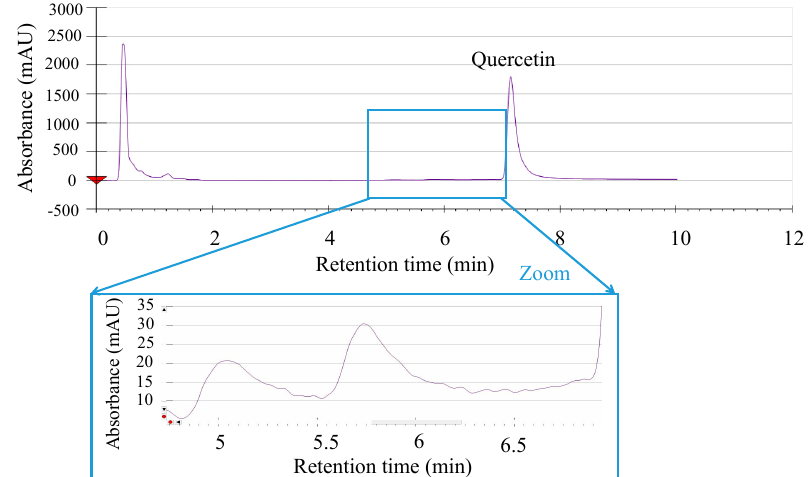
Figure 1. A supercritical fluid chromatography separation method with diode array detection (SFC-DAD) chromatogram of the separation of quercetin (eluting at approximately 7 min) from two other compounds detected that could be possible products of degradation (in zoom). SFC-DAD method: Backpressure 12 MPa, temperature 323 K, flow rate 3 mL / min, gradient from 10 to 35 volume % of ethanol in 8 min and a holding time of 2 min, DAD wavelength 200 to 600 nm with quercetin quantification at 369 nm. For more information, see Section 3.3.